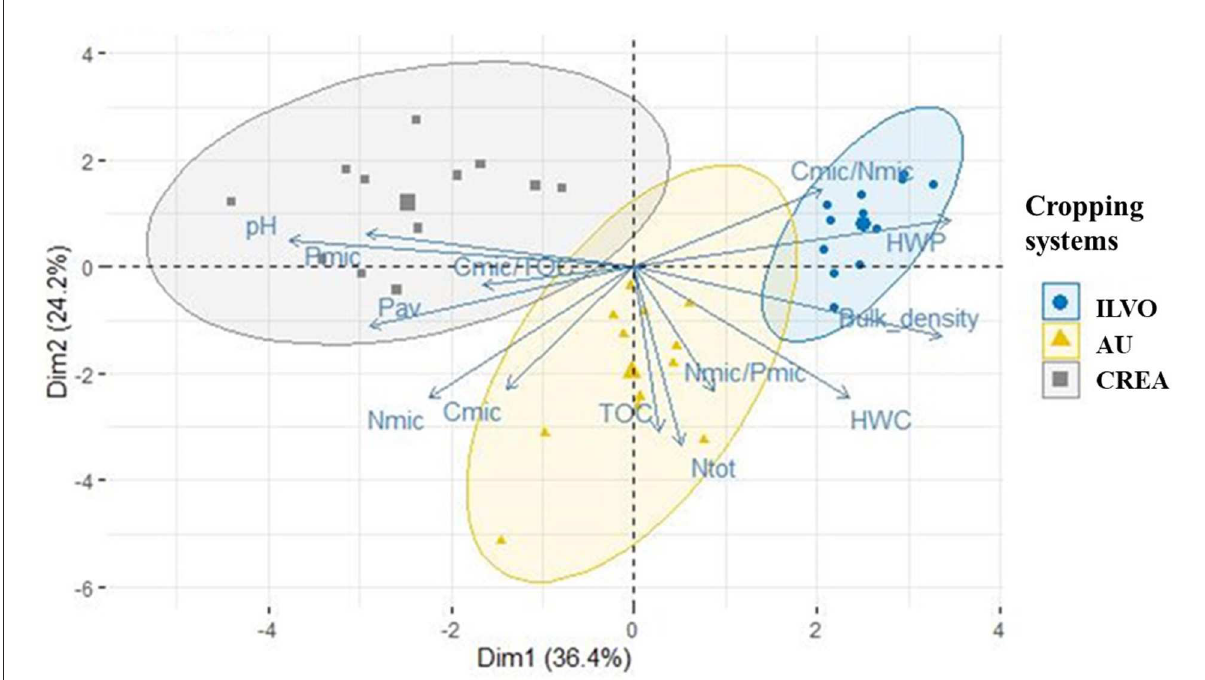
FIGURE2 Principal component analysis (PCA) biplot and confidence ellipses ordering the Belgian, Danish, and Italian experimental sites in relation to relevant soil physicochemical and biochemical parameters (bulk density, pH, N tot , P av , HWC, HWP, C mic /TOC, C mic , N mic , P mic , C mic /N mic , and N mic /P mic ) at